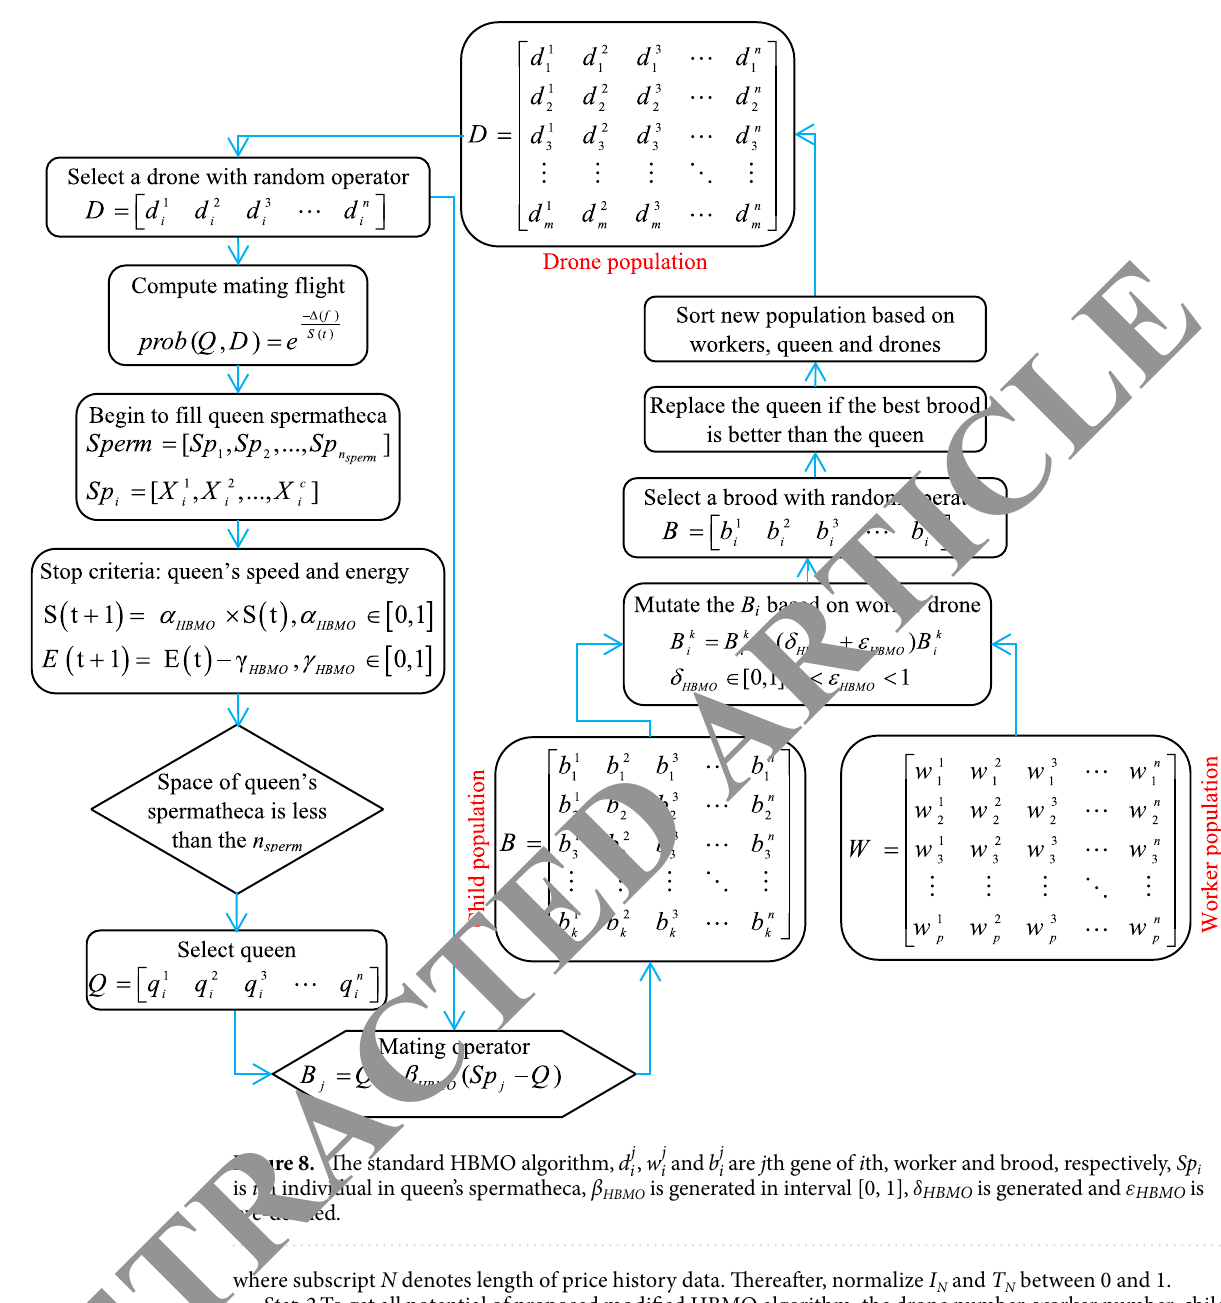
Figure 8. The standard HBMO algorithm, d is i th individual in queen’s spermatheca, β HBMO is generated in interval [0, 1], δ HBMO is generated and ε HBMO is